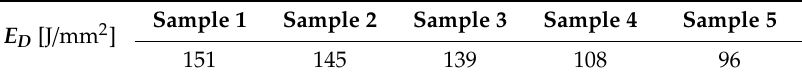
Table 5. Evaluation of weld penetration using energy density.